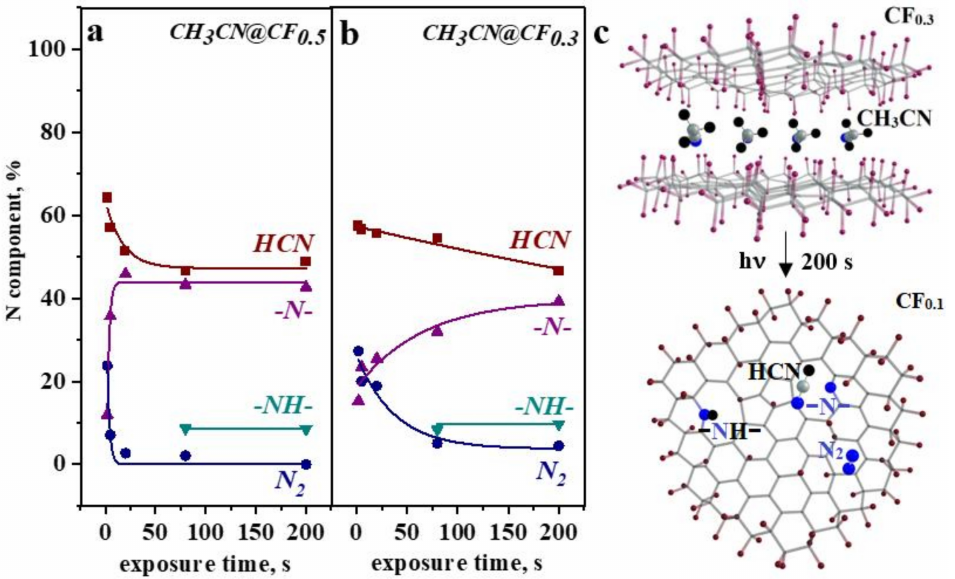
Figure 6. Dependence of the NEXAFS N K-edge components from HCN, N 2 , pyridinic N, and pyrrolic N on the time of exposure of CH 3 CN@CF 0.5 ( a ) and CH 3 CN@CF 0.3 ( b ) to white beam light. The model of evolution of CH 3 CN@CF 0.3 structure and composition under the irradiation ( c